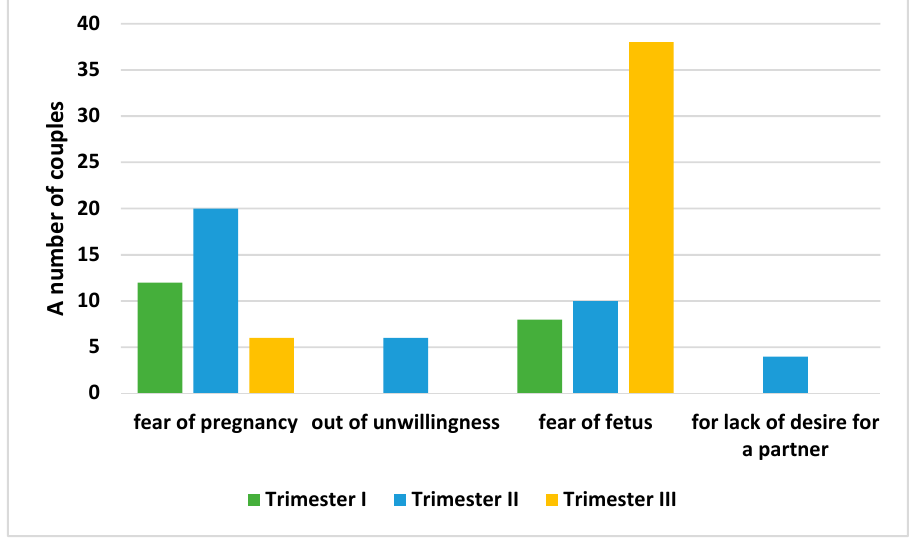
Figure 3. Reasons for sexual abstinence.